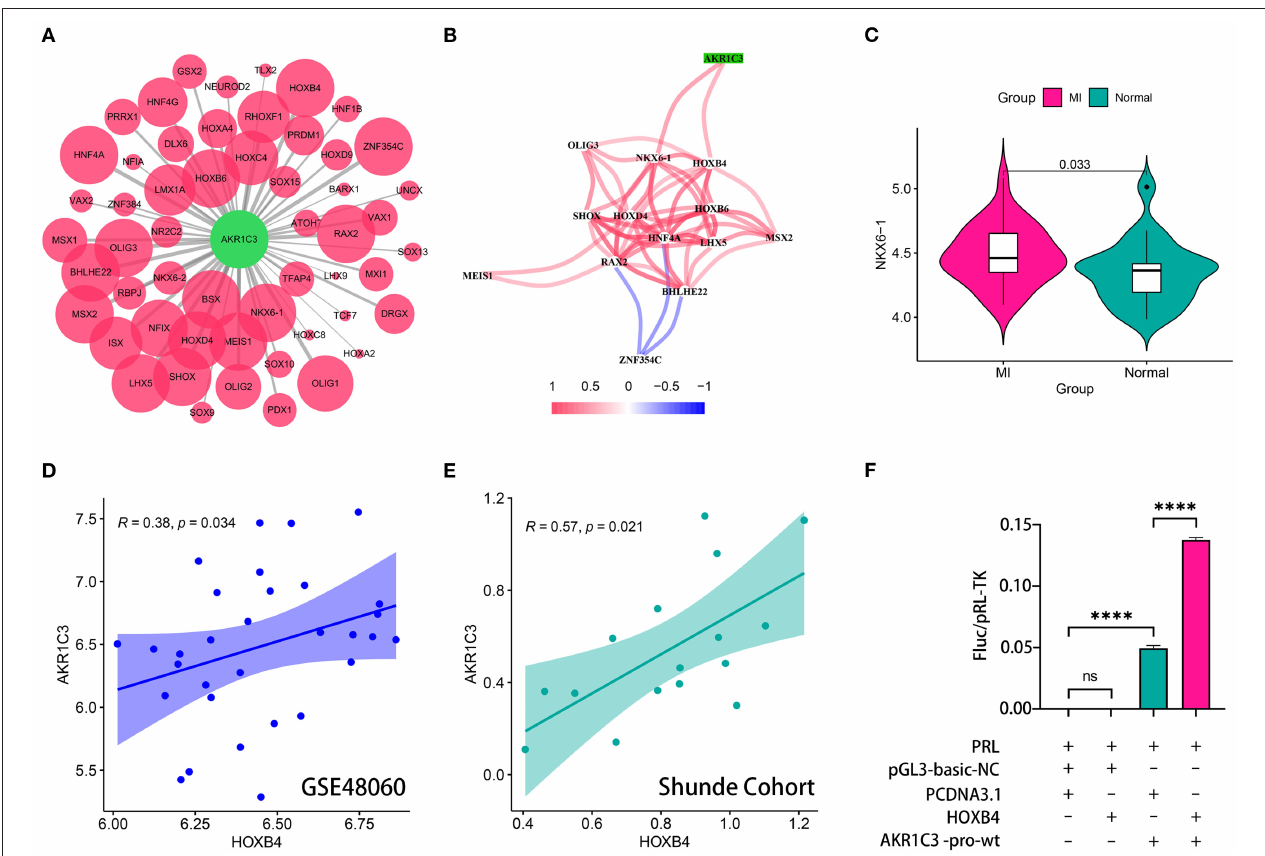
FIGURE 4 | HOXB4 served as a transcription factor for AKR1C3. (A) Prediction of the potential transcription factor of AKR1C3. The size of the circle represents the predicted possibility. (B) AKR1C3 was significantly correlated with HOXB4 and NKX6-1. (C) NKX6-1 was upregulated in acute myocardial infarction samples. (D,E) The expression values of AKR1C3 and HOXB4 were tightly associated in the GSE48060 (D) and Shunde (E) cohorts. (F) The results of the luciferase reporter assay. **** p < 0.0001; ns, not